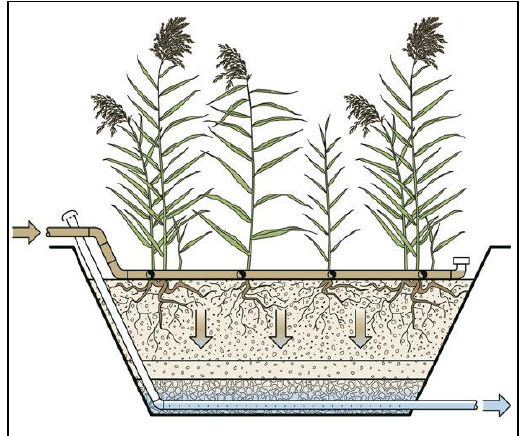
Figure 1. Classification of CWs for wastewater treatment.